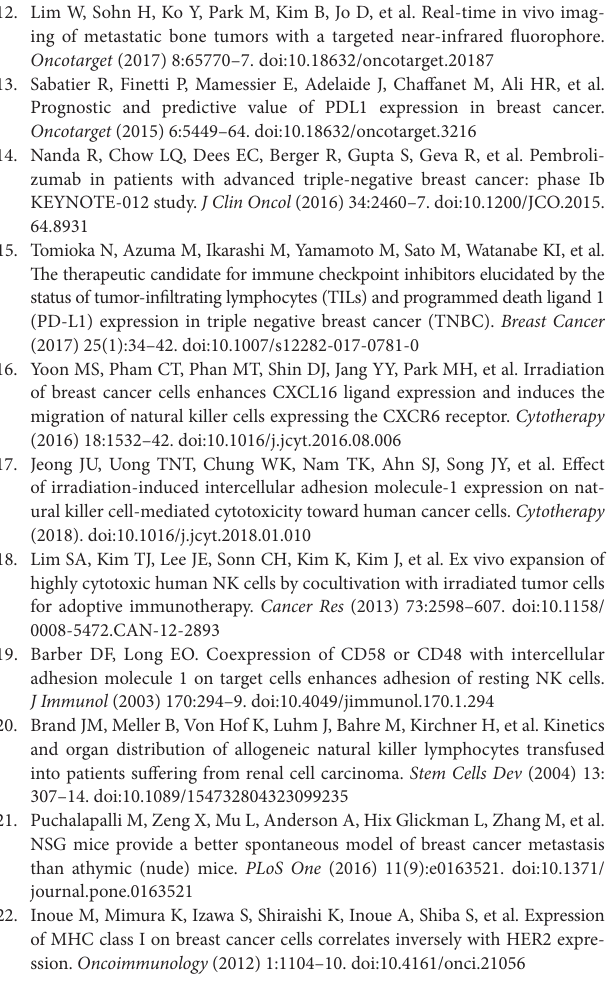
FigUre s1 | Effect of ESNF13 on natural killer (NK) cell purity at different concentrations. The representative dot plot examples of stained or unstained CD56 + CD3 − NK cells at different post-injection time points (0, 24, 48, and 72 h). FigUre s2 | Alive and dead population of natural killer (NK) cells stained with near-infrared (NIR) fluorophores. (a) The representative density plot of PI staining of living and dead populations. (B) The representative density plot examples of alive and dead population of NK cells stained with 0.1 and 0.2 μ M NIR fluorophores at different time intervals (immediately at 24, 48, and 72 h after staining). FigUre s3 | Cytotoxicity at different E:T ratio of expanded natural killer (NK) cells stained with near-infrared fluorophores ESNF13 against MDA-MB-231 human breast cancer cell lines. Expanded NK cells were stained with different concentration of ESNF13 dye (0.1 and 0.2 μ M) and checked the cytotoxicity activity and the IFN- γ release against breast human cancer cell lines MDA- MB-231 at different E:T ratio (0.5:1 and